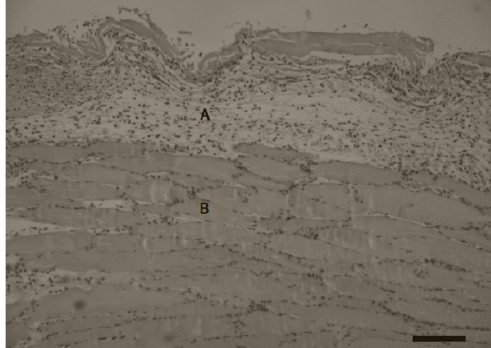
Figure 7. Hematoxylin & Eosin stained tissue section of the connective tissue capsule around expander implanted for 7 days. ( A ) Connective tissue capsule formed around implant, ( B ) muscle tissue. Scale bar = 0.5 mm. Table 5. The volume ratio ( V t / V 0 ) of polySMA-0.7 expanders removed after certain time of the implantation into rat legs.